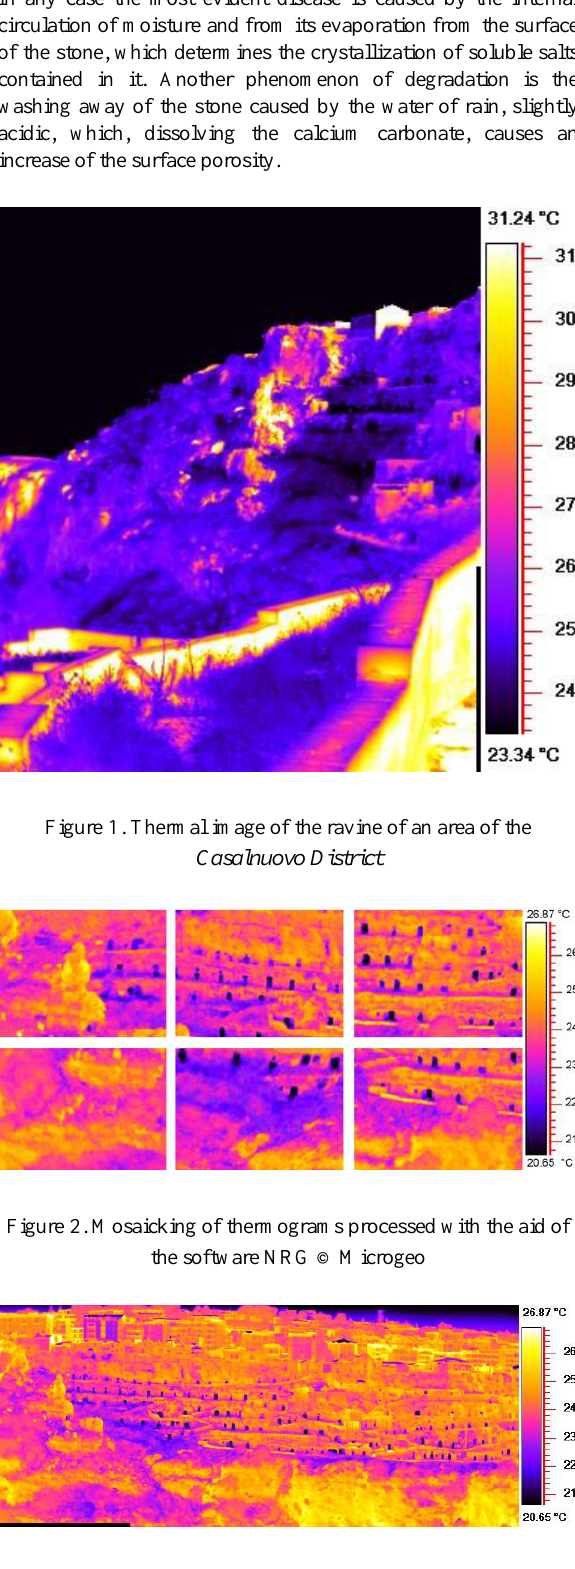
Figure 3. Results of the thermal mosaicking of a big area of the Casalnuovo